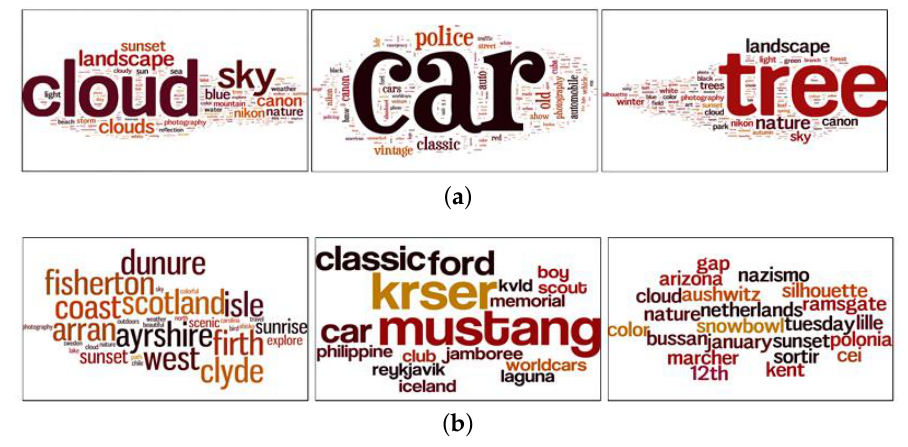
Figure 3. The gap between the number of tags associated with popular photos and unpopular photos.